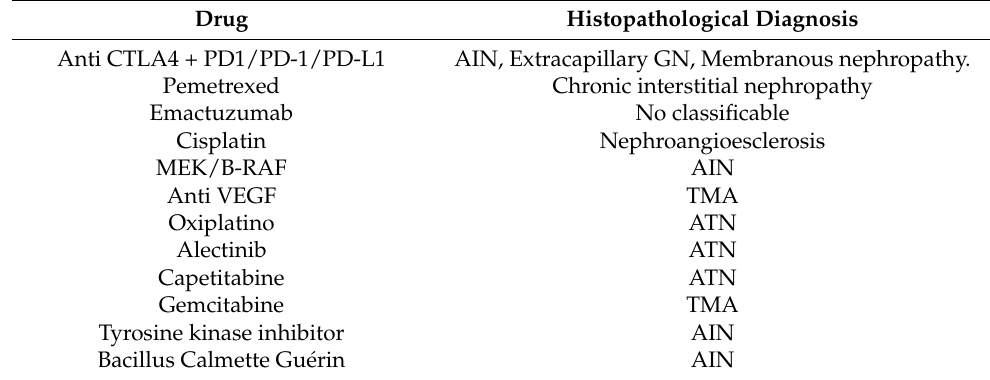
Table 7. Drugs associated with kidney